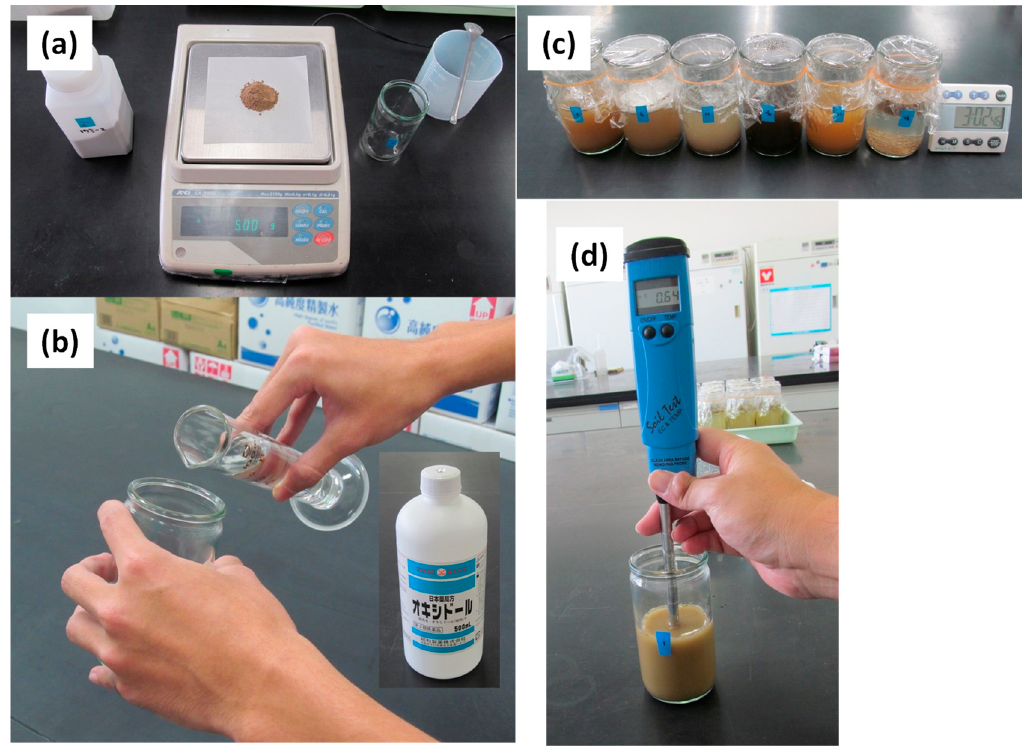
Figure 2. The original oxydol method procedure: ( a ) sub-sample measurement, ( b ) addition of 3% H 2 O 2 solution (Showa), ( c ) extraction at 25 °C for 40 h, and ( d ) measurement of EC (H 2 O 2 ), reproduced from [9] with permission from the Japanese Society of Soil Science and Plant Nutrition.